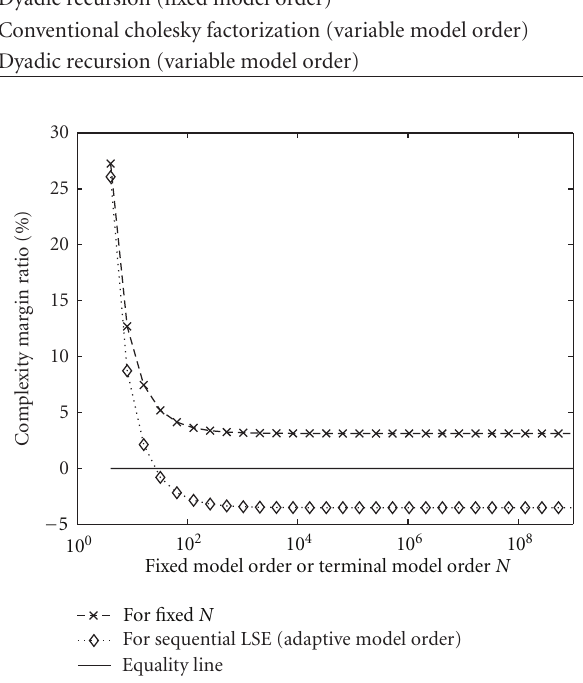
versus signal-to- opt